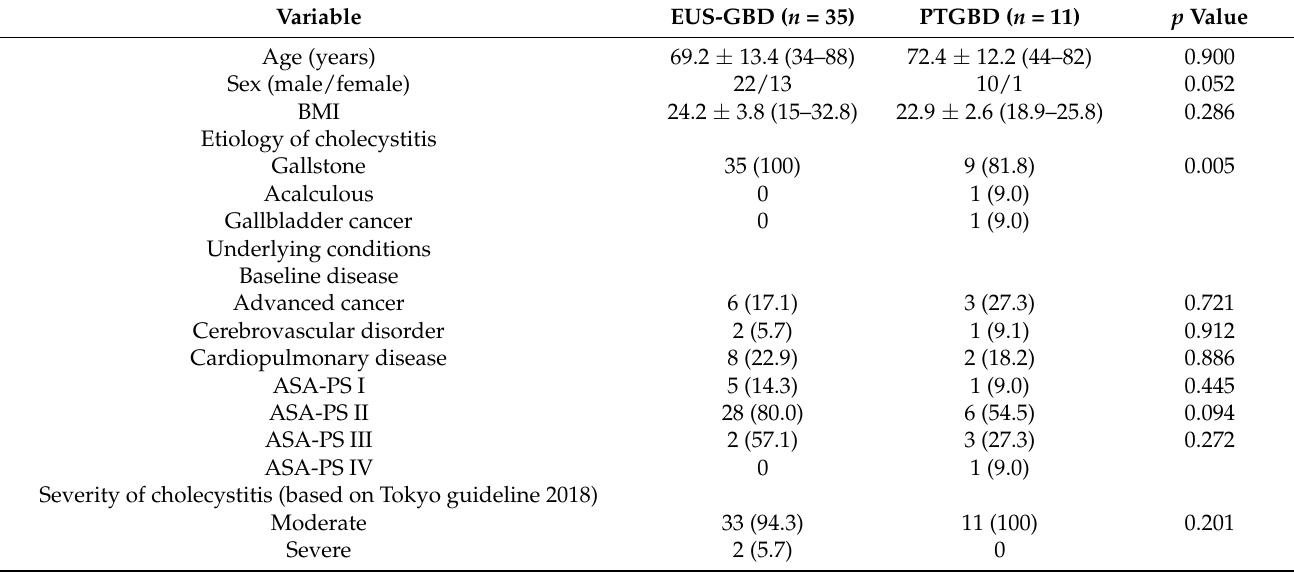
Table 1. Patient characteristics.